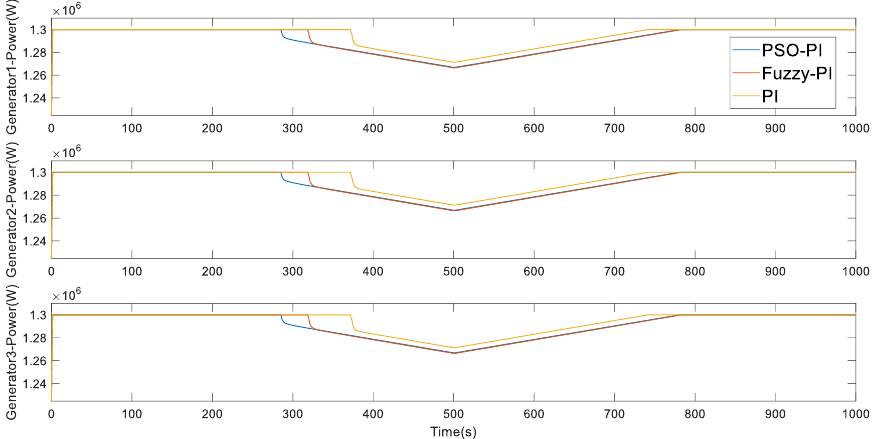
Figure 29. Output power of photovoltaic power generation unit in Example 3.